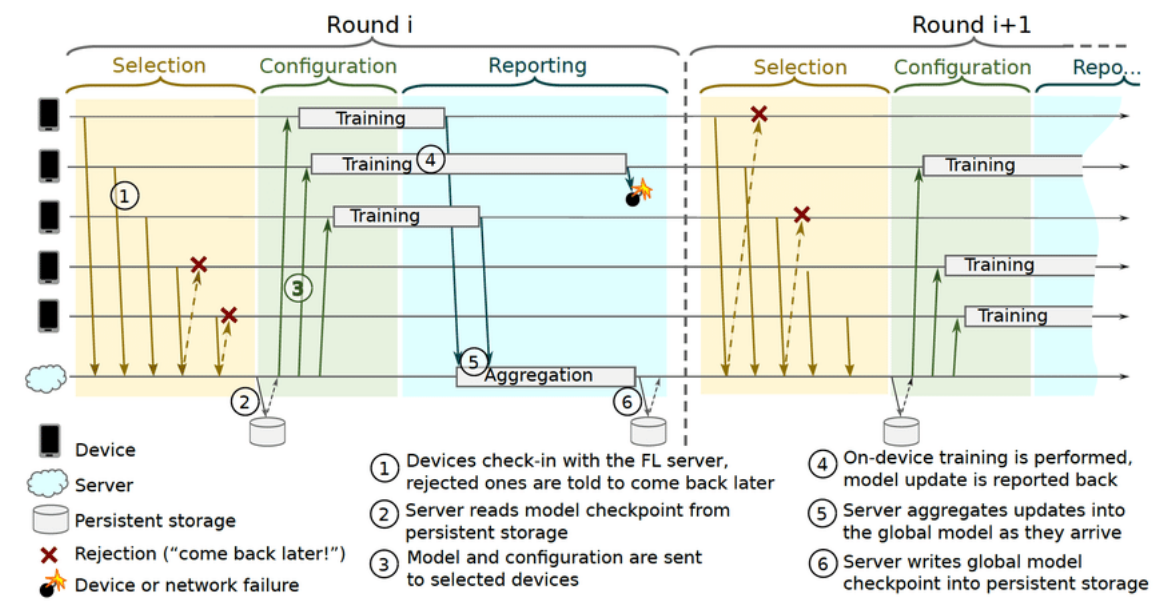
Figure 9. Federated learning protocol